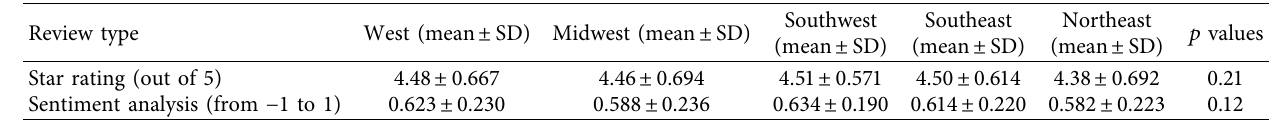
Table 6: Location analysis based on star rating and review sentiment analysis.